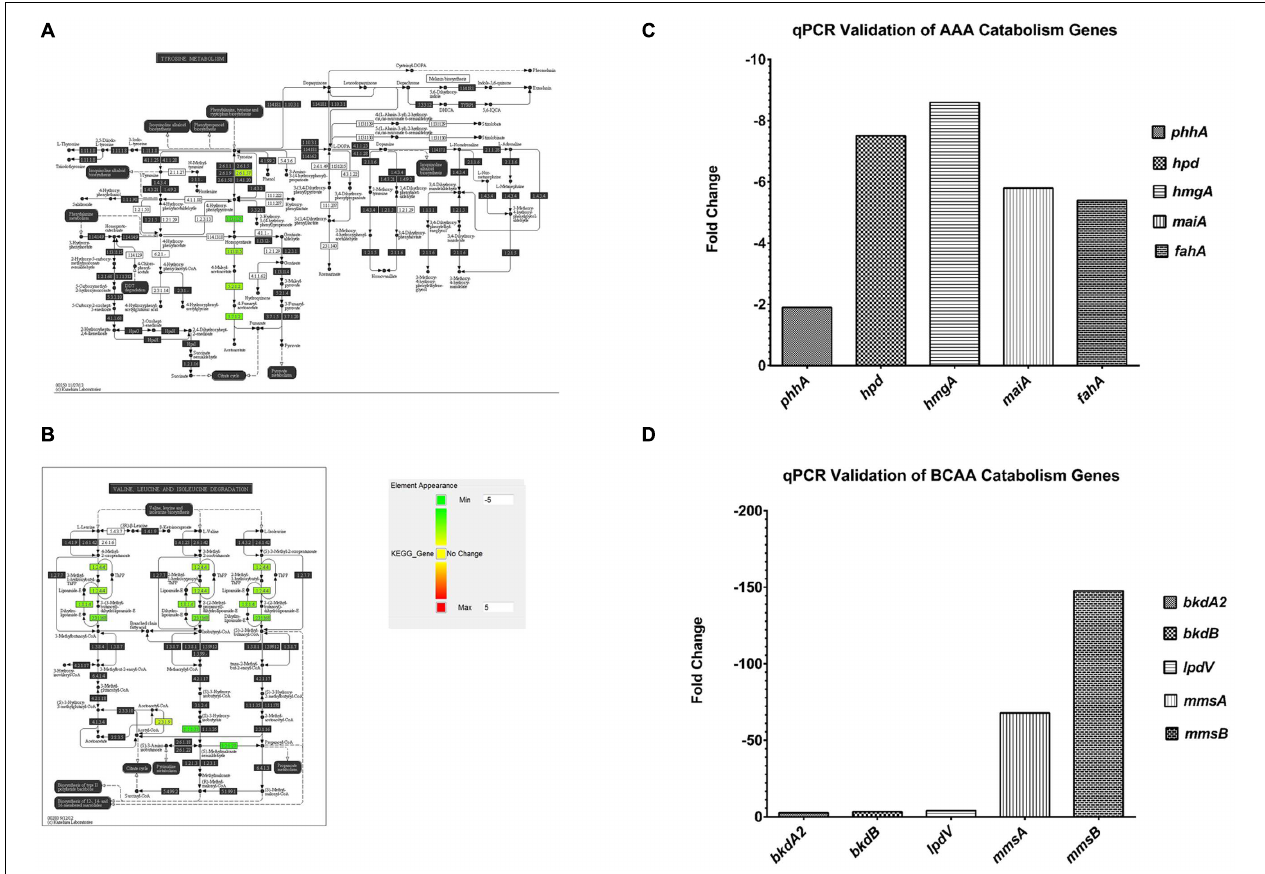
FIGURE 4 | Pathway analysis of microarray results. (A) Pathway analysis- 5 genes, phhA , hpd, hmgA, maiA and fahA from the aromatic amino acid catabolism pathway were downregulated (green). (B) Pathway analysis- 5 genes, bkdA2 , bkdB, lpdV, mmsA and mmsB from the branched chain amino acid catabolism pathway were downregulated (green). (C) A representative qPCR validation of phhA , hpd, hmgA, maiA and fahA , normalized to rpoD . (D) A representative qPCR validation of bkdA2 , bkdB, lpdV, mmsA and mmsB , normalized to rpoD .